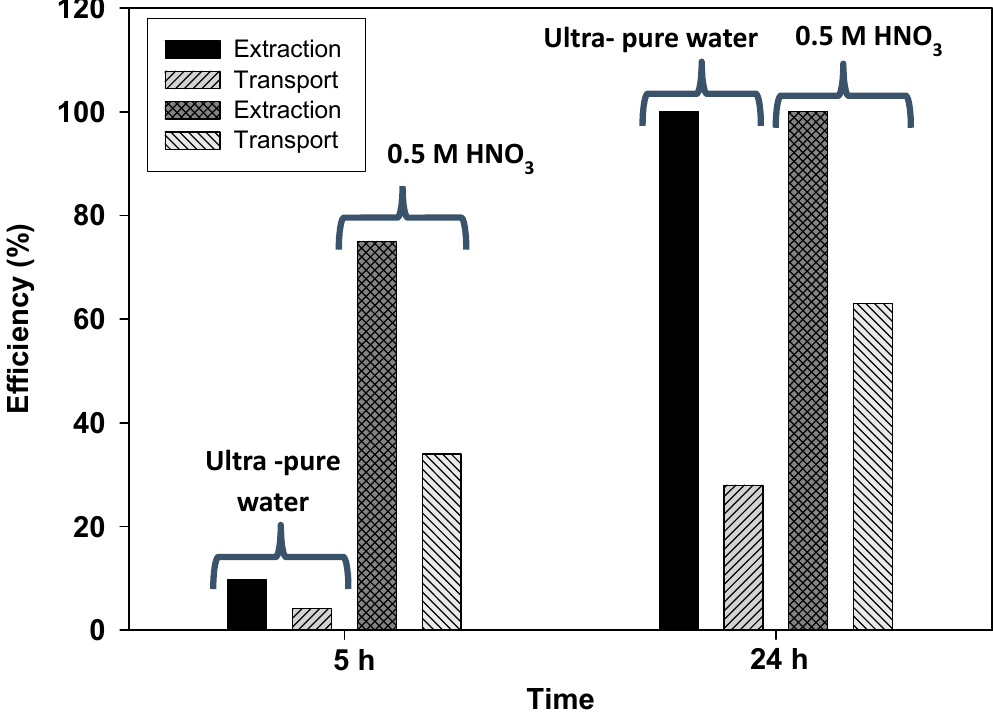
Figure 3. Effect of the stripping phase composition on Cd extraction and recovery vs. time. Feed phase: 0.5 mg L − 1 Cd in 0.5 M NaCl. PIM 2.